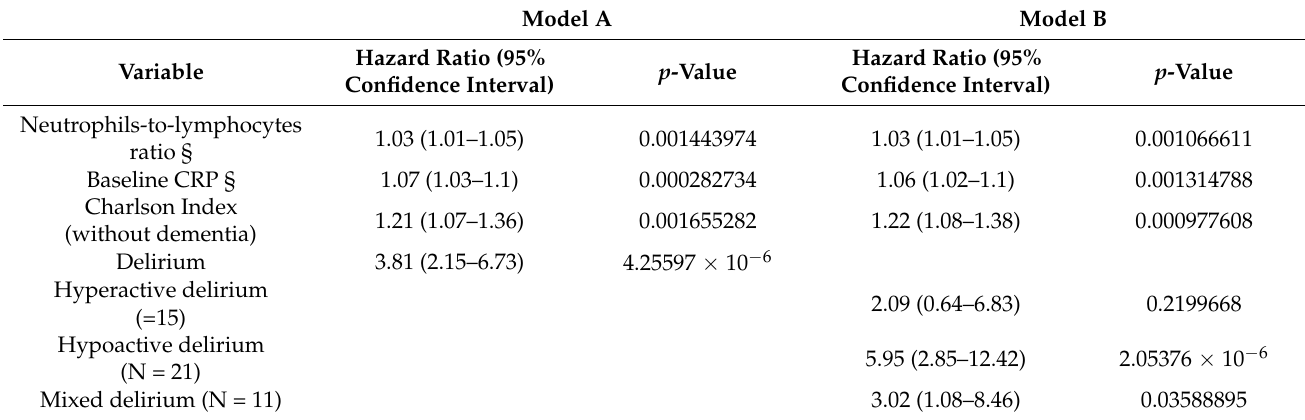
Table 7. Predictors of poor outcome (death or admission to ICU) in the multivariable model. Model A Model